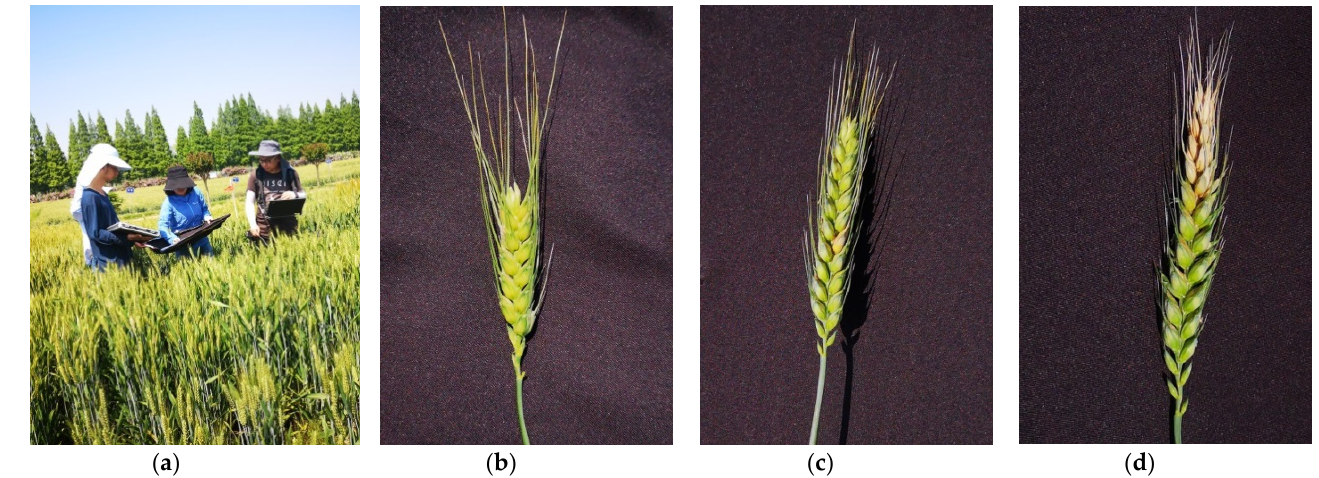
Figure 2. Field survey and FHB-infected ear of winter wheat the three diseases severity: ( a ) field survey, ( b ) healthy wheat ears, ( c ) wheat ears with mild infection, ( d ) wheat ears with severe infection.